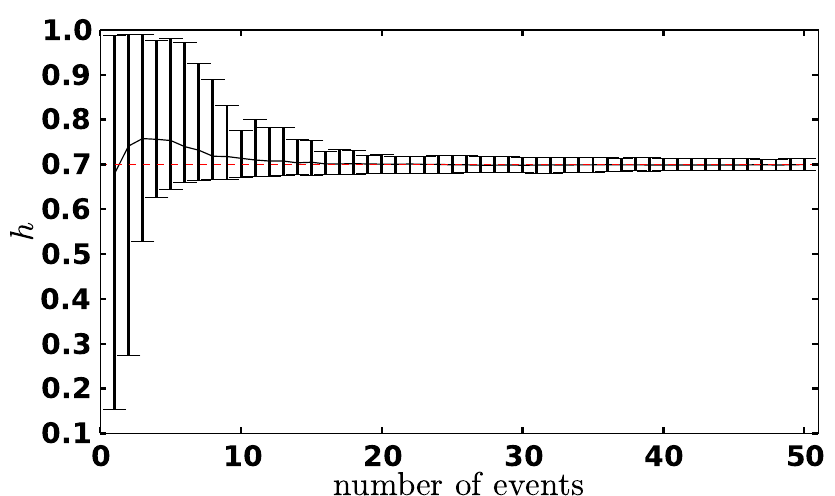
Figure 20. Forecasted determination of the Hubble constant H 0 with dark siren events with redshift inferred from galaxy catalogs. From Del Pozzo